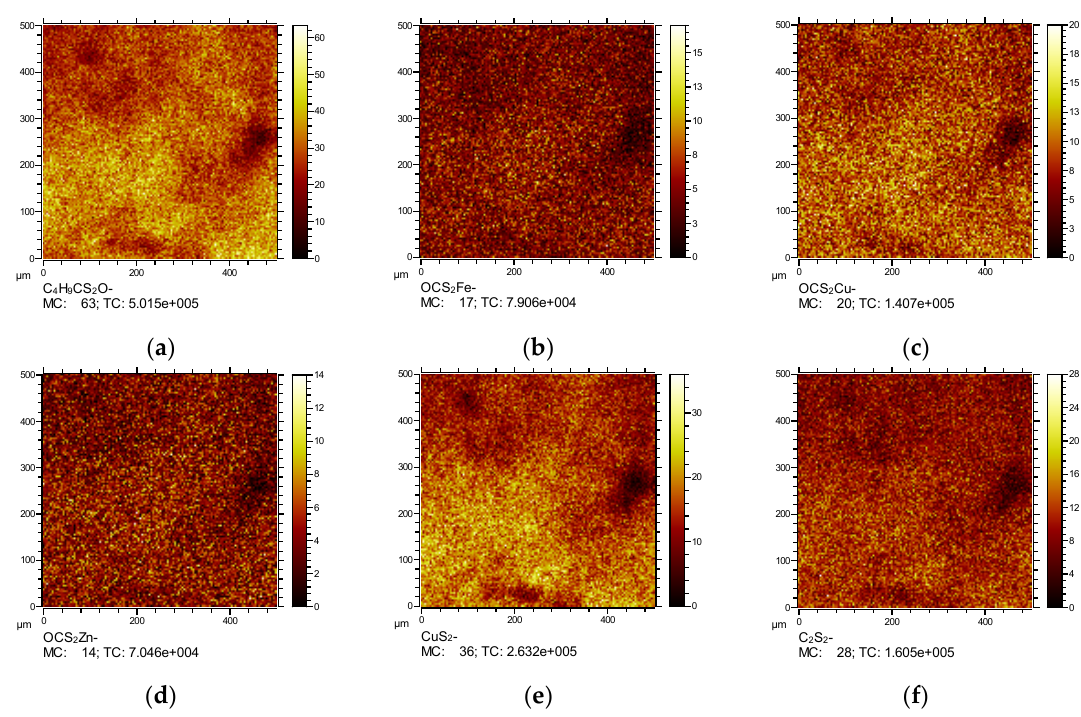
Figure 7. ToF-SIMS negative-ion images of Cu-activated marmatite surface after interaction with BX at pH 6.5. ( a ): C 4 H 9 CS 2 O − ; ( b ): OCS 2 Fe − ; ( c ): OCS 2 Cu − ; ( d ): OCS 2 Zn − ; ( e ): CuS 2− ; ( f ): C 2 S 2− .